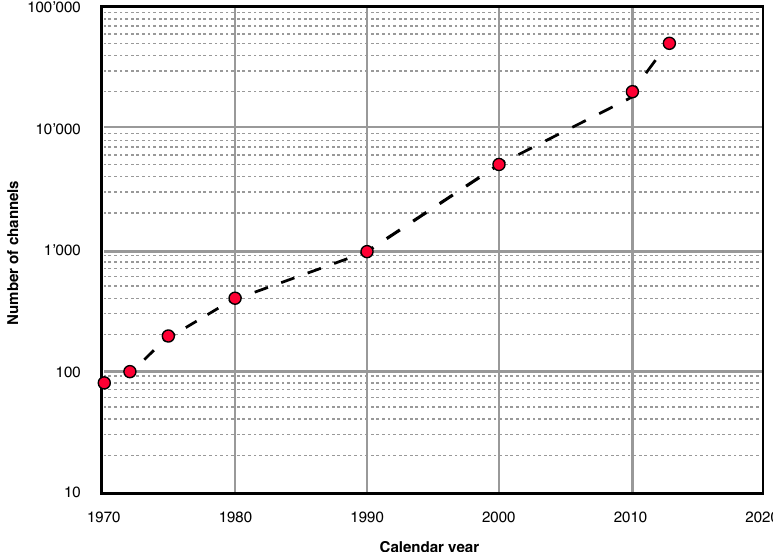
Figure 7. History of land seismic recording system channel count versus calendar year modified after Reference